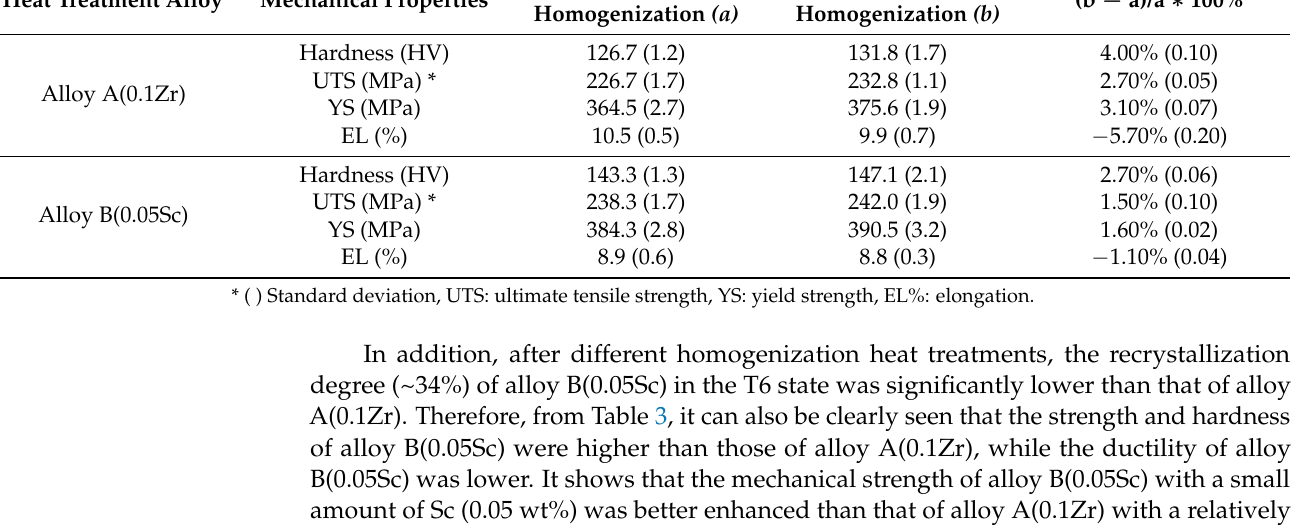
Table 3. Al–Zn–Mg mechanical properties of alloy A(0.1Zr) and alloy B(0.05Sc) by different homogenization conditions. Heat Treatment Alloy Mechanical